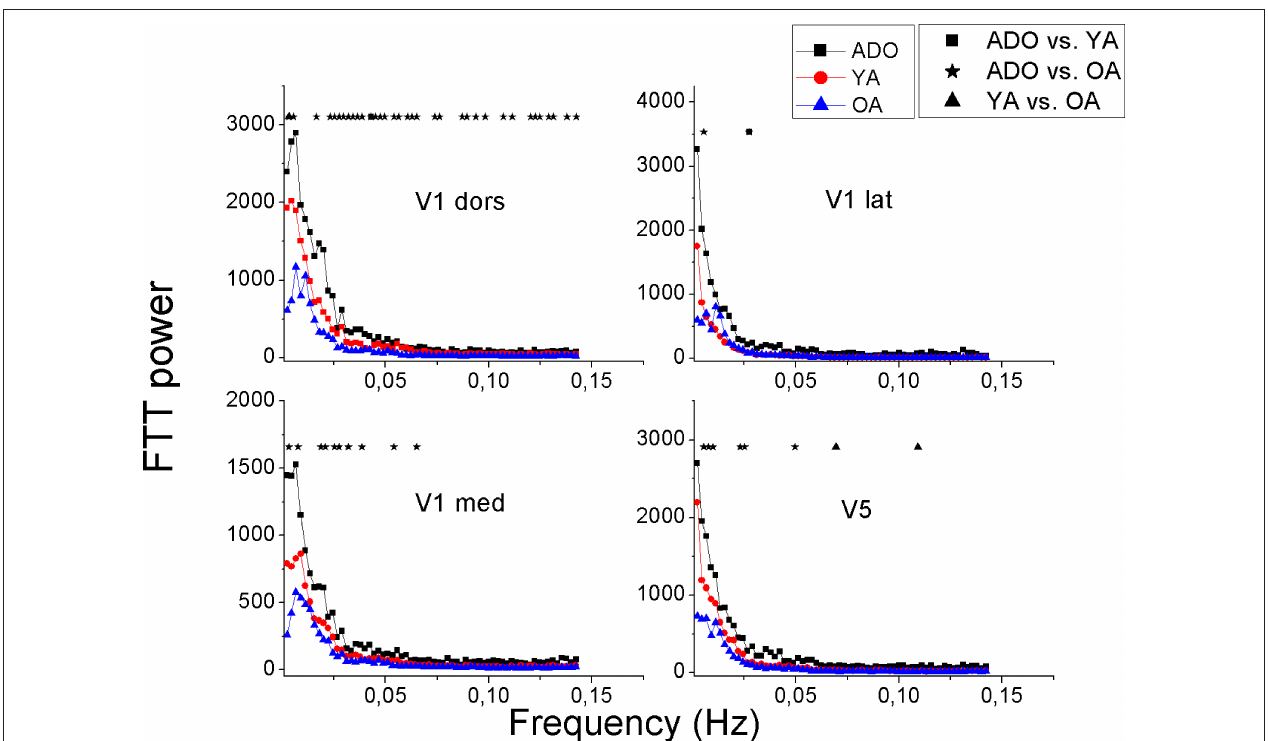
Figure 8 | Mean power spectra of Visual signal sources with identical illustration of groups and significant changes as in Figures 3 and 6. The signal sources are shown in Figure 7